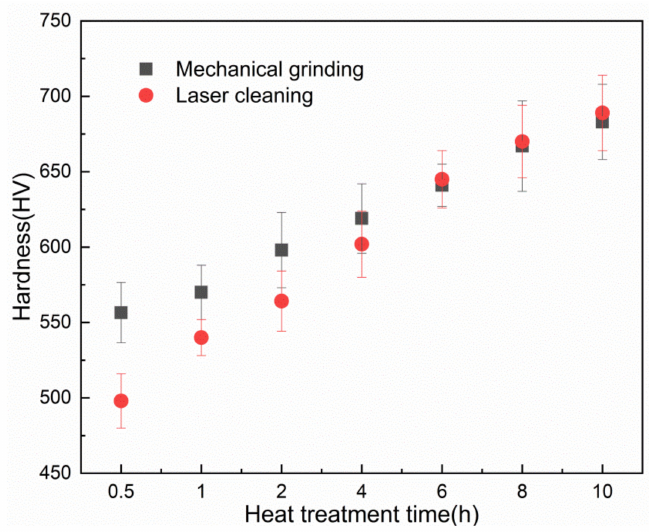
Figure 14. Hardness plot of the laser-cleaned and un-cleaned areas on the tube